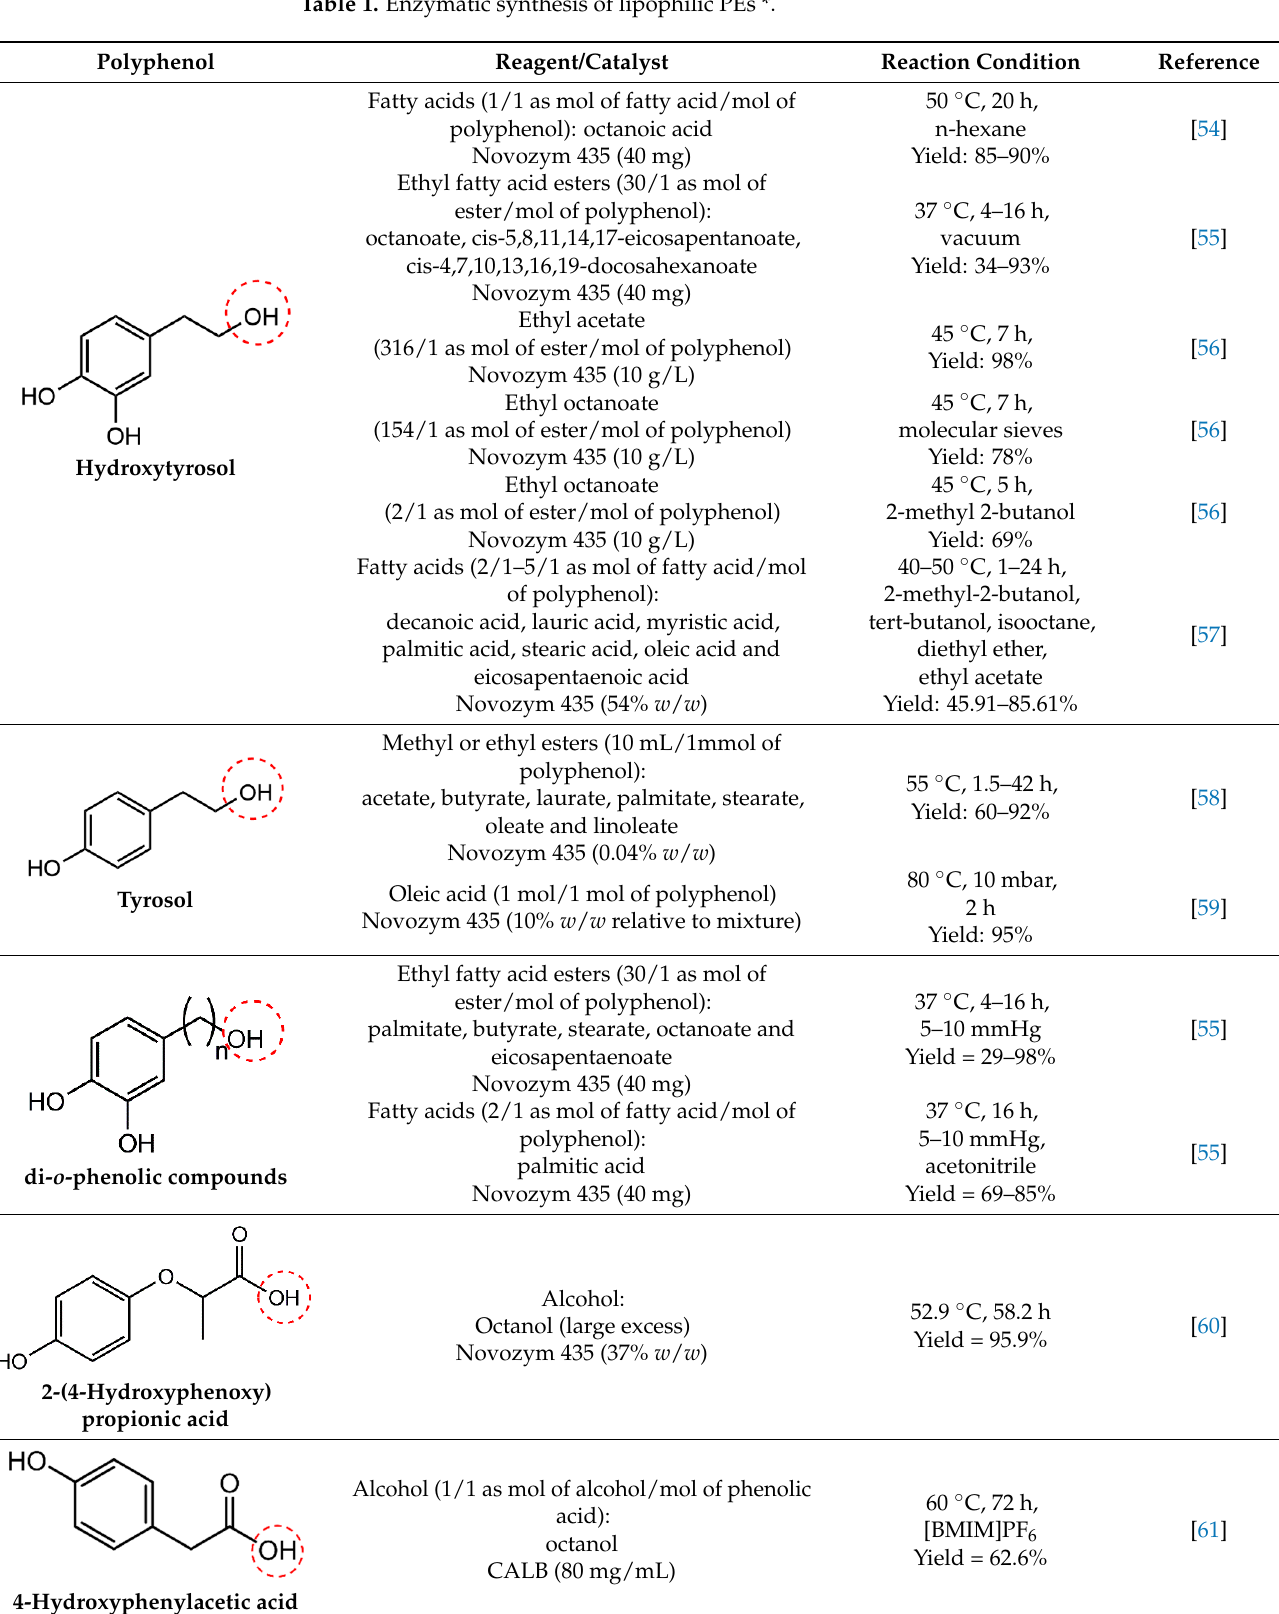
Table 1. Enzymatic synthesis of lipophilic PEs *.